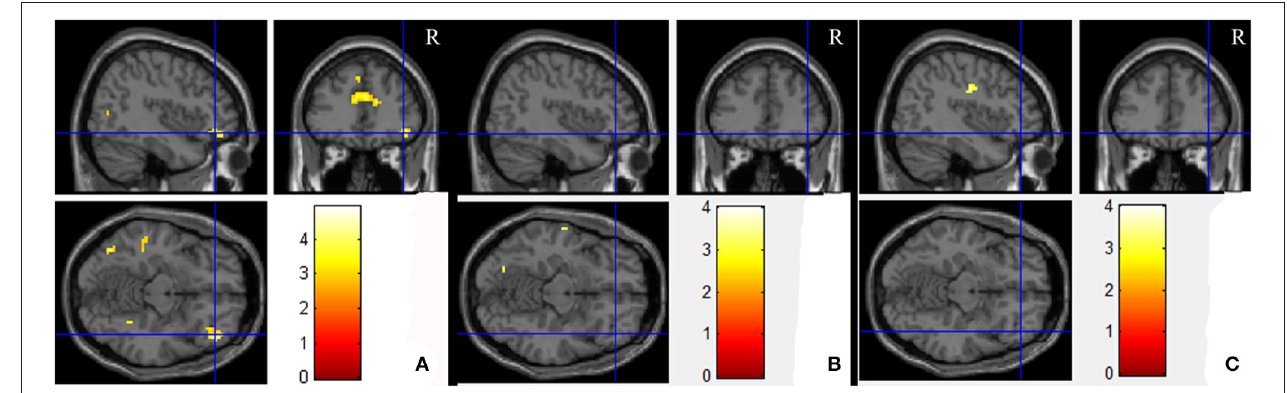
FIGURE 5 | The average brain activation map for the UPO higher than PO in the NC, MCI, and AD groups (paired t -test, uncorrected p < 0.001, extent threshold = 70). (A–C) Are NC, MCI, and AD, respectively.